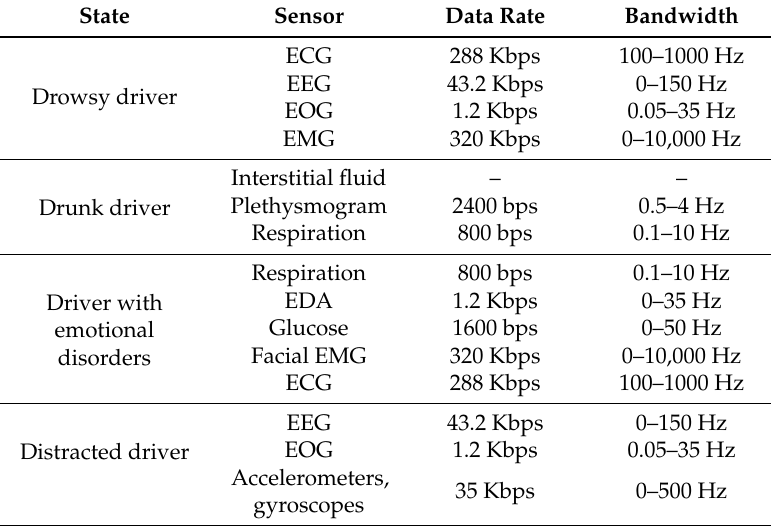
Table 1. Sensors to detect four behavior states that cause driving impairments.